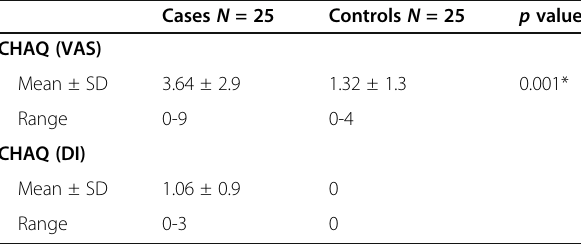
Table 1 Childhood health assessment questionnaire